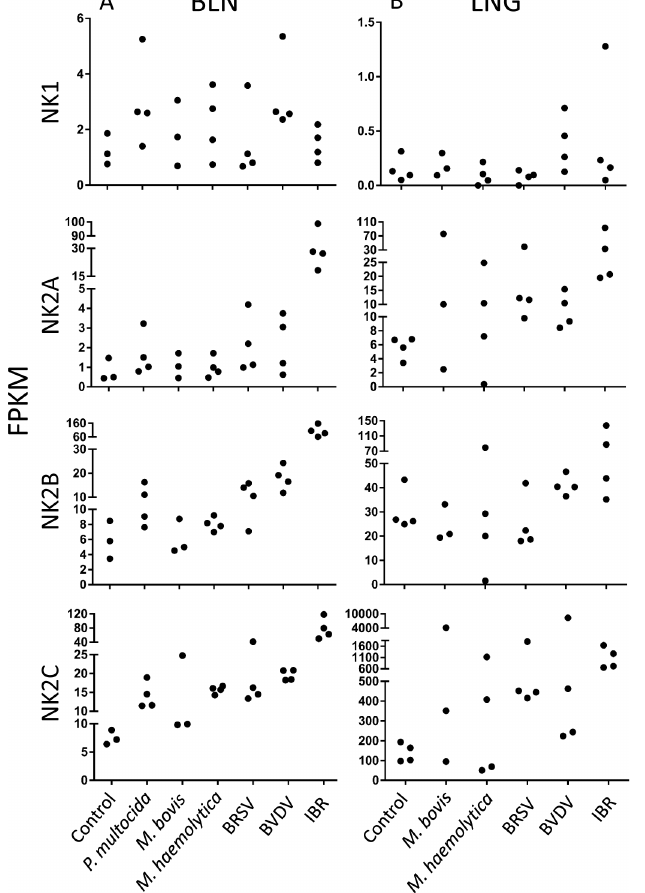
Fig 1. Expression of four bovine NK-lysin genes in bronchial lymph node (BLN, left panel) and lung (LNG, right panel) among healthy animals and animals challenged with P . multocida , M . bovis , M . haemolytica , BRSV, BVDV and IBR. The Y axis shows the FPKM value, and each black dot represents the FPKM value of an individual. Three or four individuals were included in each control and challenged group.